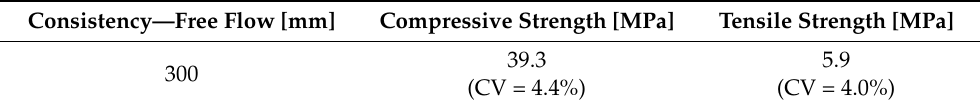
Table 3. Average compressive, tensile strength and consistency of prepared mortar.